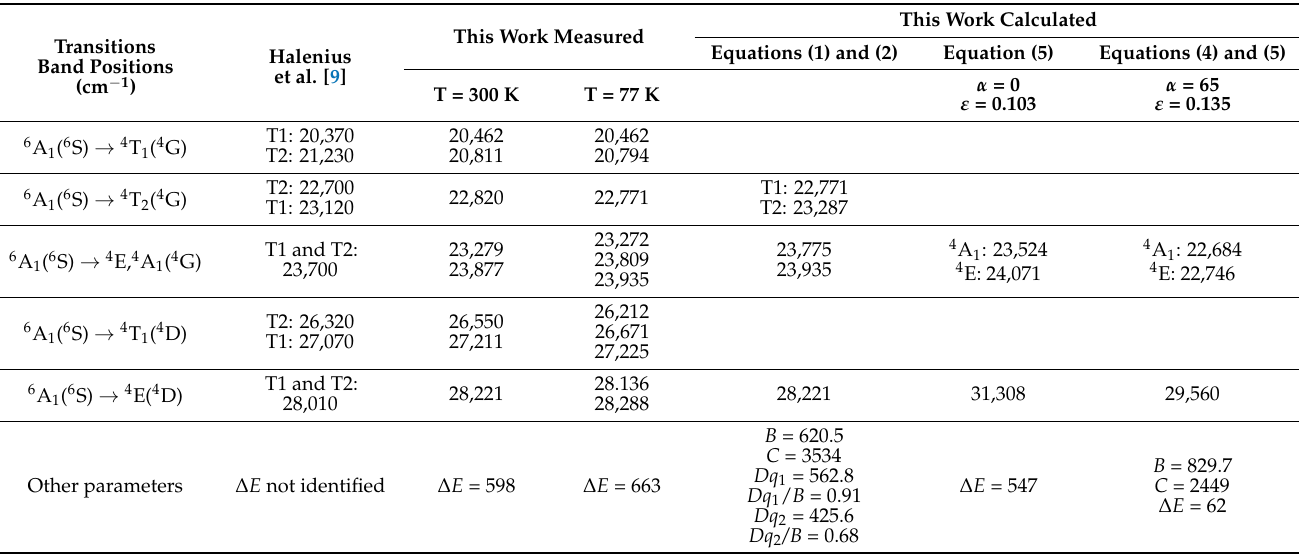
Table 10. The measured and calculated Mn 2+ -bands for willemite sample